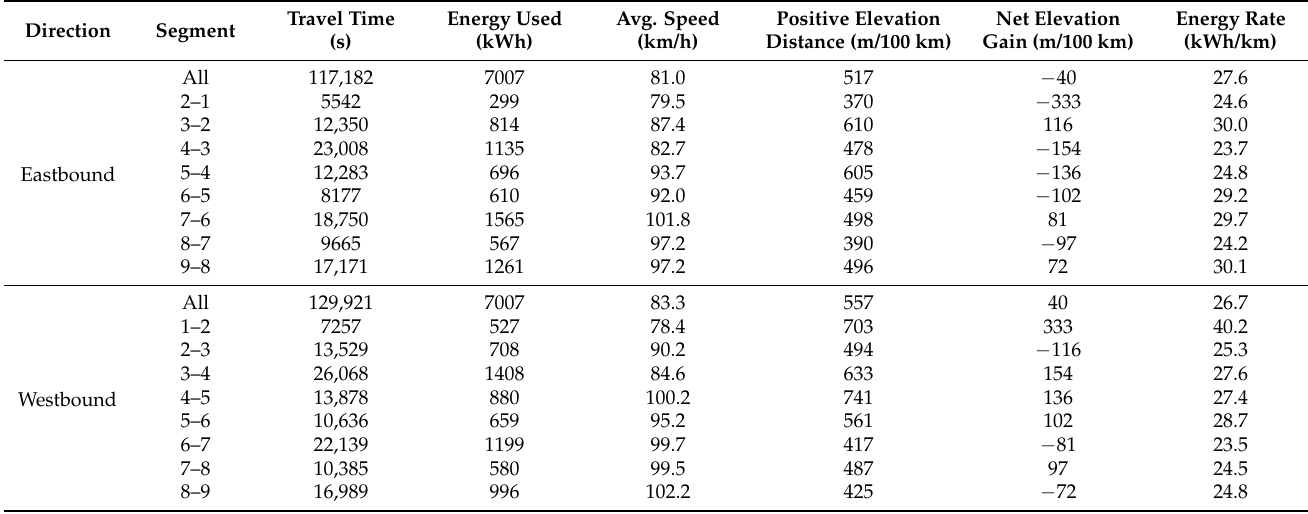
Table 3. Energy consumption by station